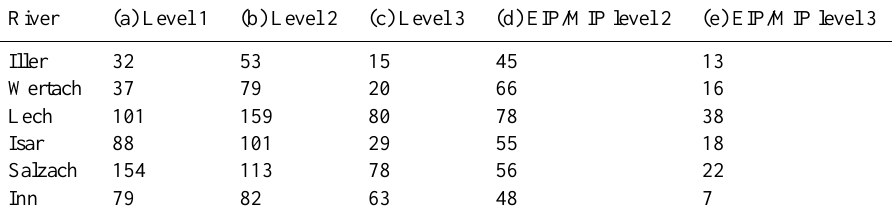
Table 3. Synoptic table of the data basis for flood frequency in the Bavarian Foreland. Columns (a) – (c) contain all outer-Alpine flood events of documentary evidences until 1880, segmented at intensity levels. Columns (d) and (e) contain all floods derived from instrumental periods until 2008 for one representative gauge per river. EIP: early instrumental period, MIP: modern instrumental